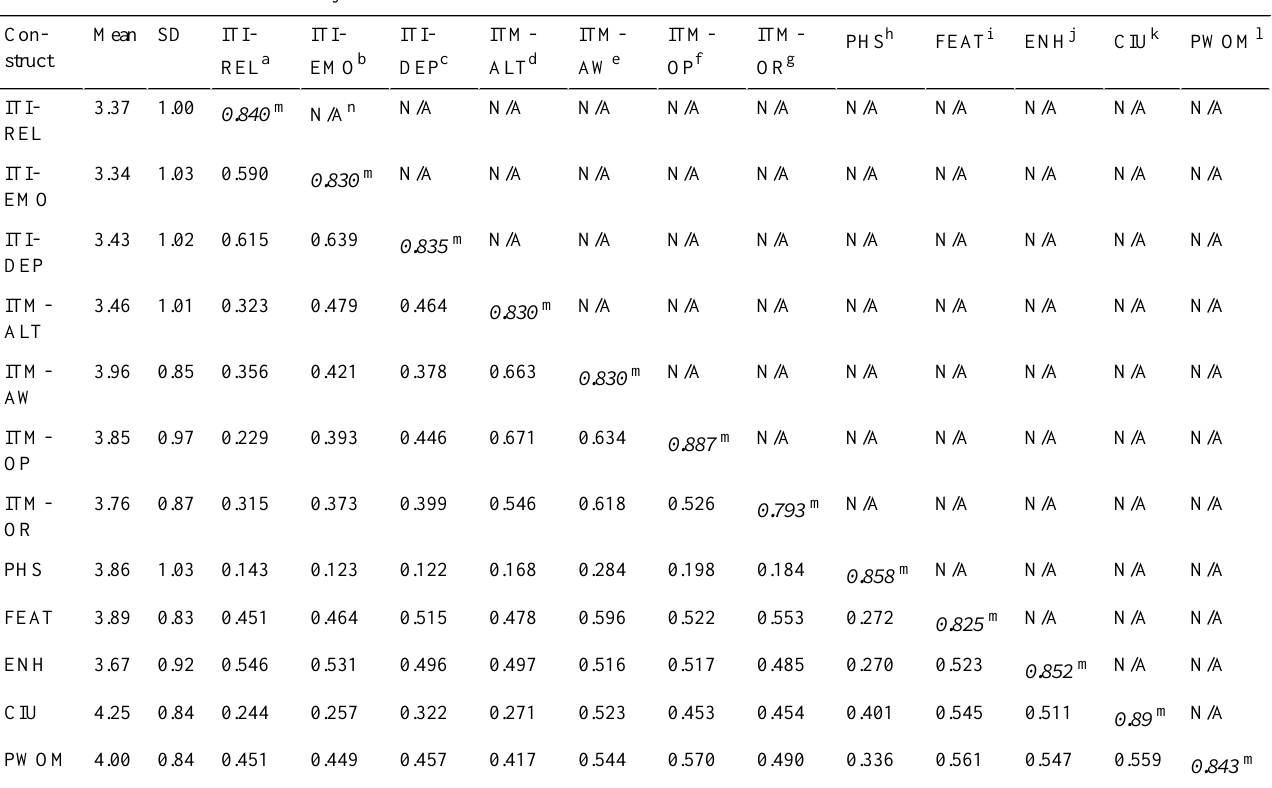
Table 4. Results of discriminant